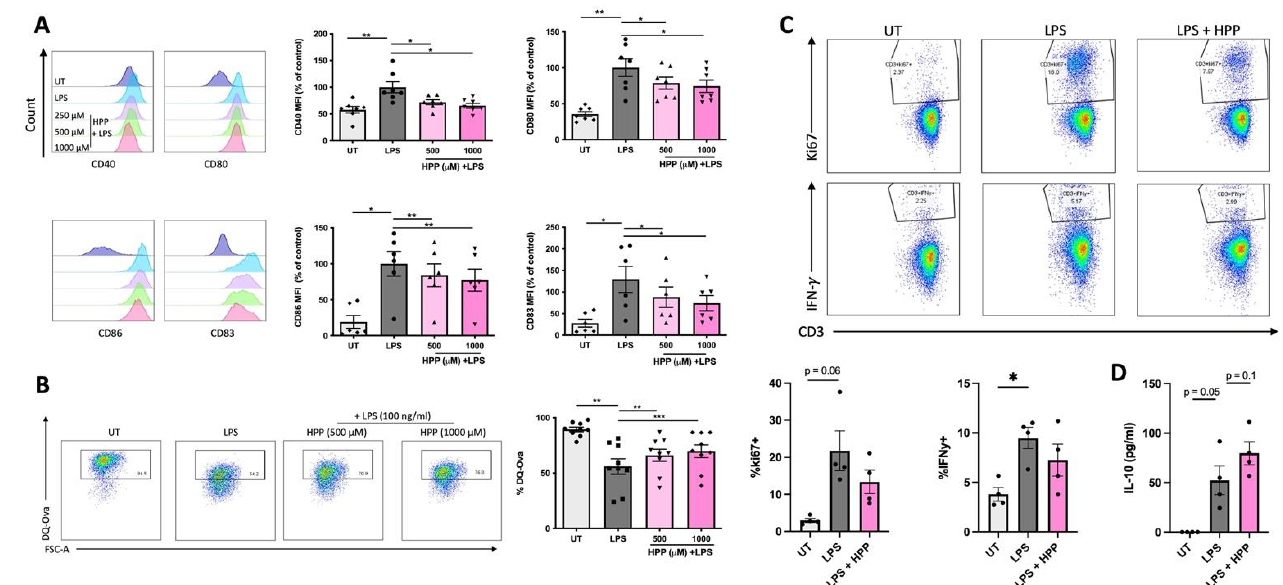
Figure 4. HPP treatment reduces DC maturation and subsequent CD4 + T cell activation. Primary human DC were left untreated (UT) or incubated with HPP (500–1000 µ M) for 6 h prior to stimulation with LPS (100 ng/mL) for 24 h. ( A ) Cells were stained for CD40, CD80, CD86, and CD83 and analysed by flow cytometry. Histograms showing the expression of maturation markers for HPP-treated, LPS-stimulated DC compared to unstimulated cells or LPS stimulation alone from one representative experiment. Pooled data showing the mean ( ± SEM) MFI for each marker expressed as a percentage of control (LPS stimulation alone) from six to seven healthy donors. ( B ) DC were incubated with FITC-conjugated DQ-Ovalbumin (DQ-Ova; 500 ng/mL) for 20 min and were immediately acquired by flow cytometry. Dot plots depicting DQ-Ova uptake from one representative experiment. Pooled data showing the mean ( ± SEM) DQ-Ova uptake as a percentage of total cells from nine healthy donors. ( C ) DC were pre-treated with HPP prior to stimulation with LPS, and subsequently cultured with CD4 + T cells for five days. Dot plots depicting ki67 expression (as a measure of proliferation) and IFN γ expression from one representative experiment. Pooled data showing the mean ( ± SEM) of ki67 + and IFN γ + cells as a percentage of CD3 + CD8 − cells from four healthy donors. ( D ) Cell supernatants were assessed for IL-10 secretion by ELISA. Pooled data depict mean ( ± SEM) cytokine concentrations for four healthy donors (means of three technical replicates per donor). Repeated mea- sures one-way ANOVA, with Dunnett’s multiple comparisons post hoc test, was used to determine statistical significance by comparing means of treatment groups against the mean of the control group (*** p < 0.001, ** p < 0.01, * p <